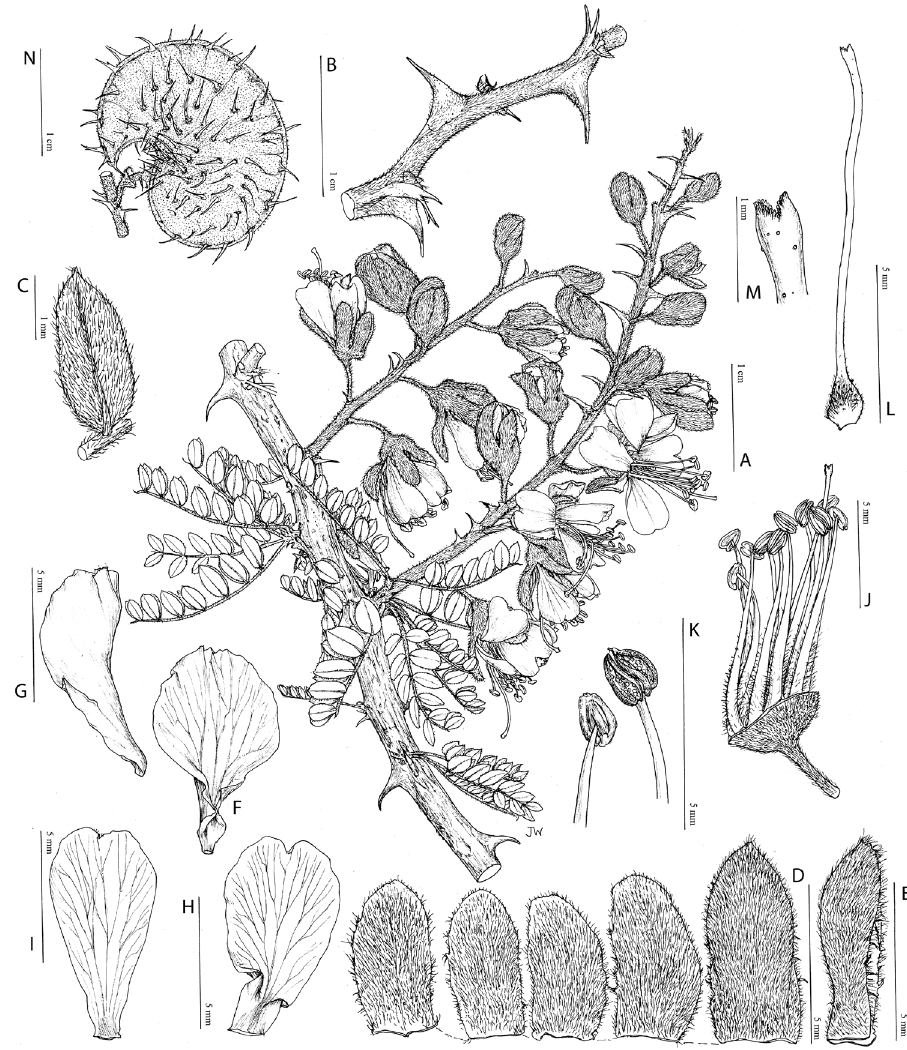
Figure 4. Hererolandia pearsonii (L. Bolus) E. Gagnon & G. P. Lewis. A foliage and inflorescences B stem armature detail C leaflet lower surface D calyx lobes outer surface E lower cucullate calyx lobe side view F median petal inner surface G median petal side view H upper lateral petal inner surface I lower lateral petal inner surface J stamens and part of gynoecium, with calyx lobes removed K anthers dorsal and ventral views L gynoecium M stigma detail, N fruit. A, C–M from Müller 1006, B, N from Geiss et al. 5156. Drawn by Juliet